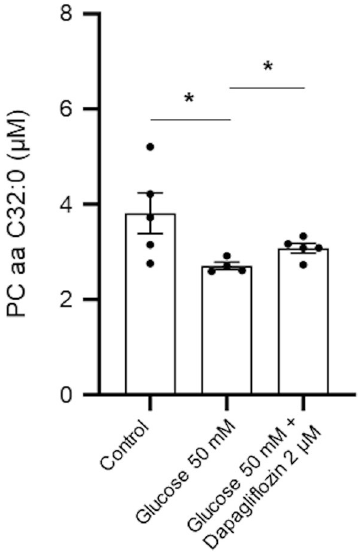
Figure 4. Box plots of differentially expressed metabolite levels in podocytes treated with 2 µM dapagliflozin following 50 mM glucose compared to the level of metabolite identified in those without treatment or treated with 50 mM glucose. * p < 0.05 indicates the significant difference between the groups by unpaired nonparametric Mann–Whitney test.